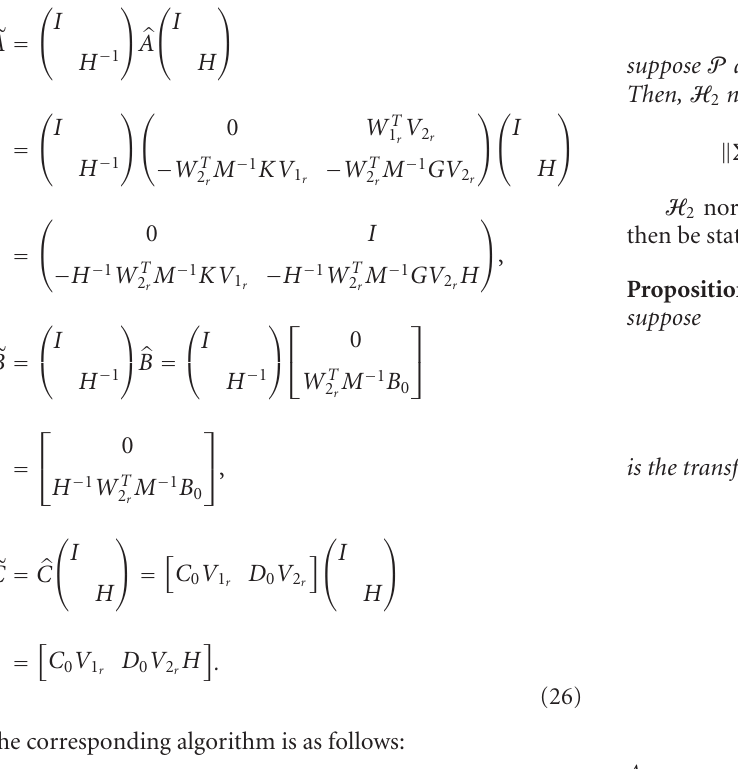
Algorithm 2 (Balanced truncation method based